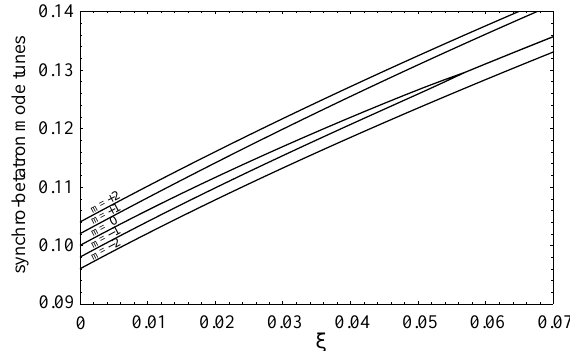
FIG. 10. Synchrobetatron mode tunes vs j for constant chro- maticity x (cid:1) 0.409 ; other parameters are the same as in Fig. 8. beam-beam interaction length, but this effect can be ex- actly compensated by the ion ring chromaticity. For zero chromaticity some modes are unstable (Fig. 8), but it is possible to stabilize all of them at a certain positive value of x (Fig. 9). This value does not depend on the beam-beam parameter j , so this is a perfect cure for the instability.